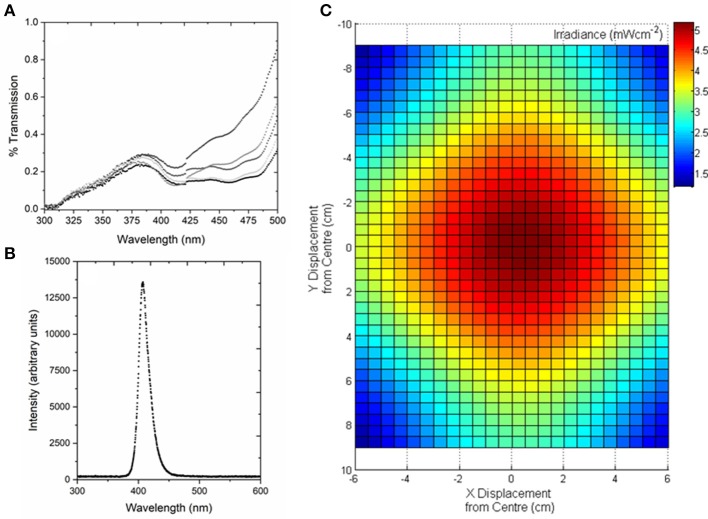
Optical characterization of human platelet concentrates, and the 405-nm light treatment system used for exposure of platelet concentrates. (A) Transmission of human platelet concentrates. Analysis demonstrates the slight variation in optical properties between batches (n = 5). Measured by UV-Vis spectrophotometry using a wavelength scan between 300 and 500 nm. (B) Optical emission spectrum of the 405-nm LED array, measured using a high resolution spectrometer (HR4000 Ocean Optics Inc, Germany) and SpectraSuite software (Version 2.0.151). (C) Model demonstrating the irradiance profile across the area of the platelet bag, with irradiance of ~5 mWcm−2 at the center (plotted using MATLAB R2012b software).